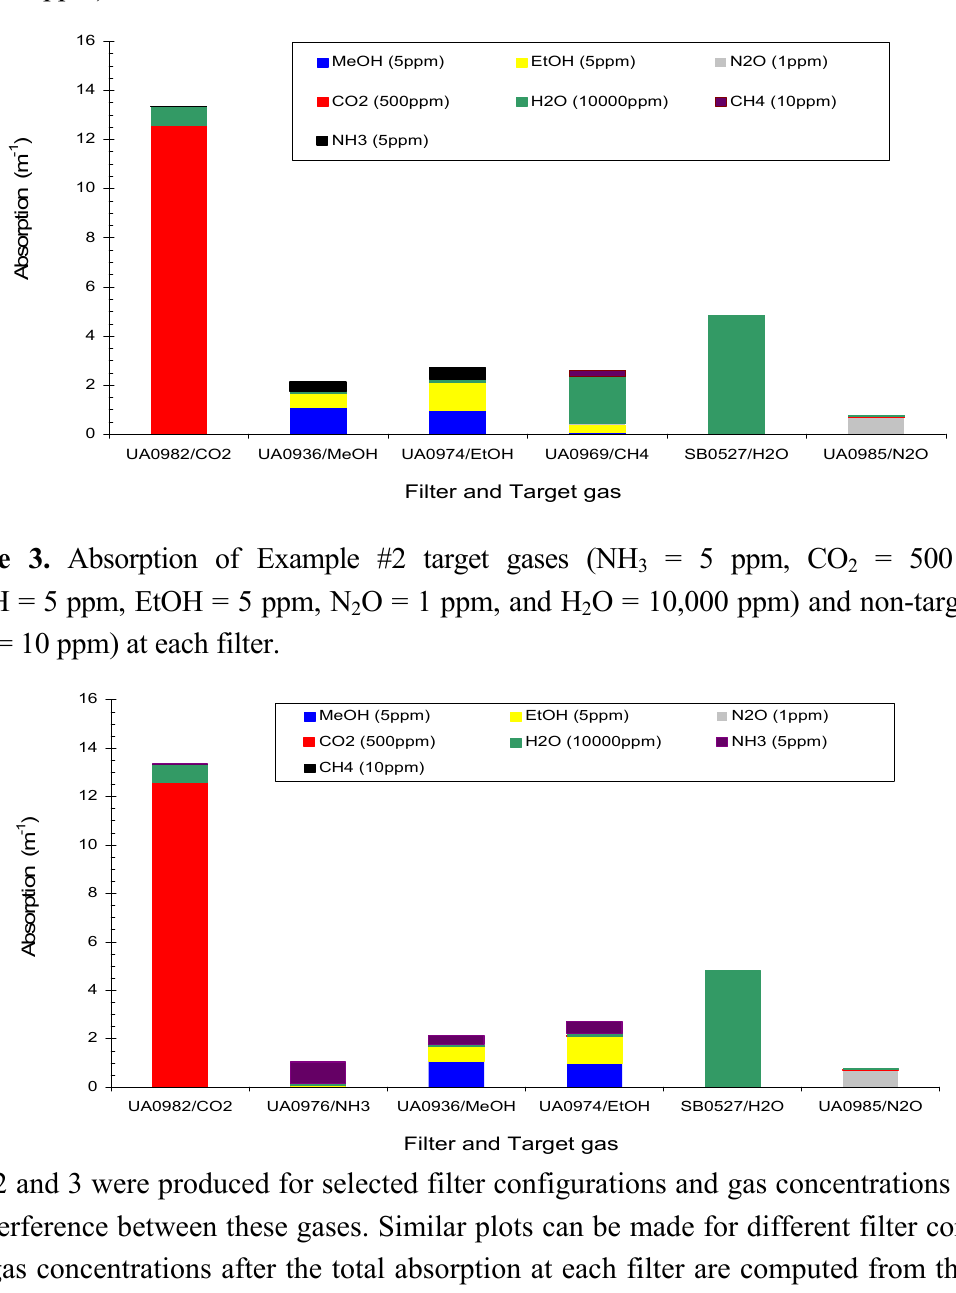
Figure 2. Absorption of Example #1 target gases (CH MeOH = 5 ppm, EtOH=5 ppm, N (NH = 5 ppm) at each filter. 3